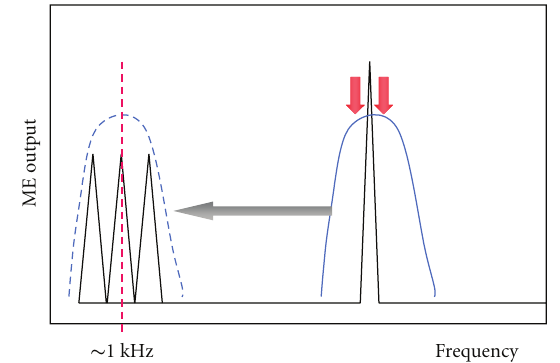
Figure 10: Schematic diagram of the goal to achieve wideband ME behavior @ ∼ 1 kHz by generating multiresonances and merging